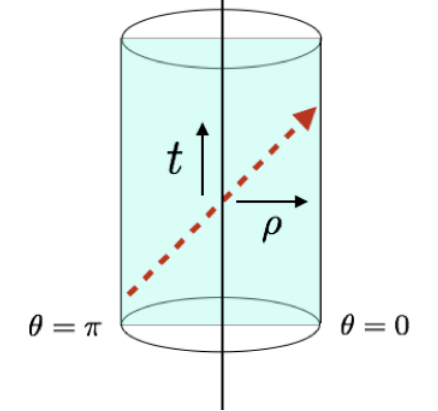
Figure 1 . The geometry of global AdS 3 . Red line is null ray, on which we compute averaged null energy. On blue plane we compute null energy, and null direction is set as that of the red line.